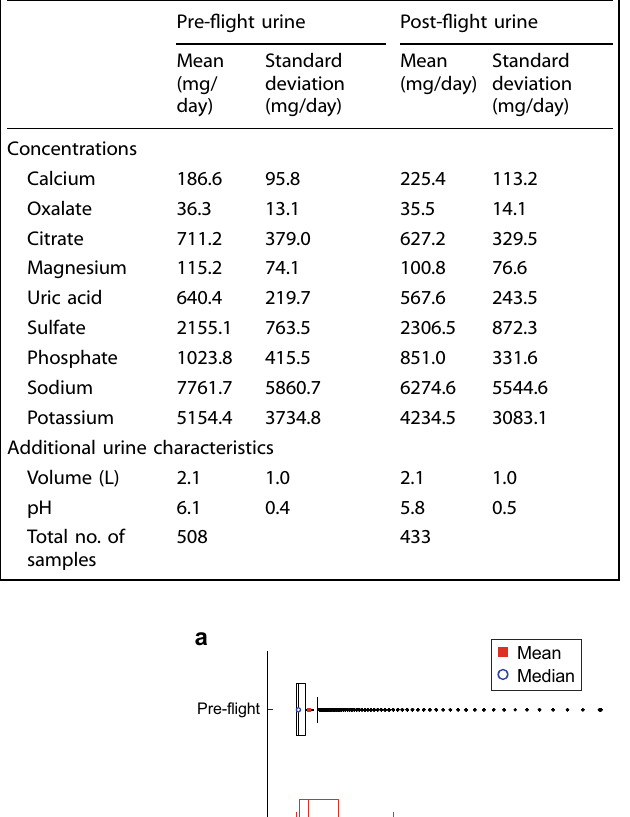
Table 1. Pre- fl ight and post- fl ight urine concentrations used to train the model.